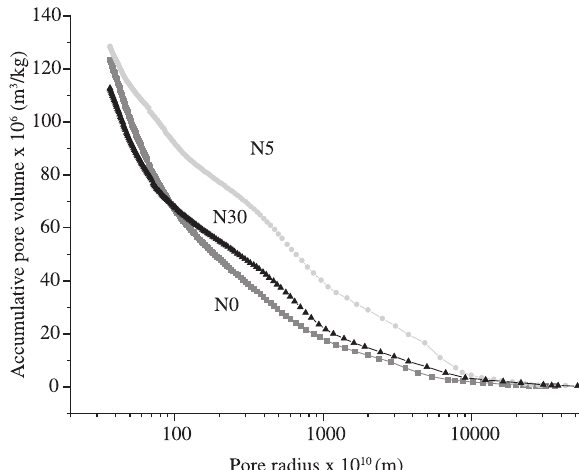
Figure 6. Pore size distribution of N0, N5 and N30 samples hydrated for 28